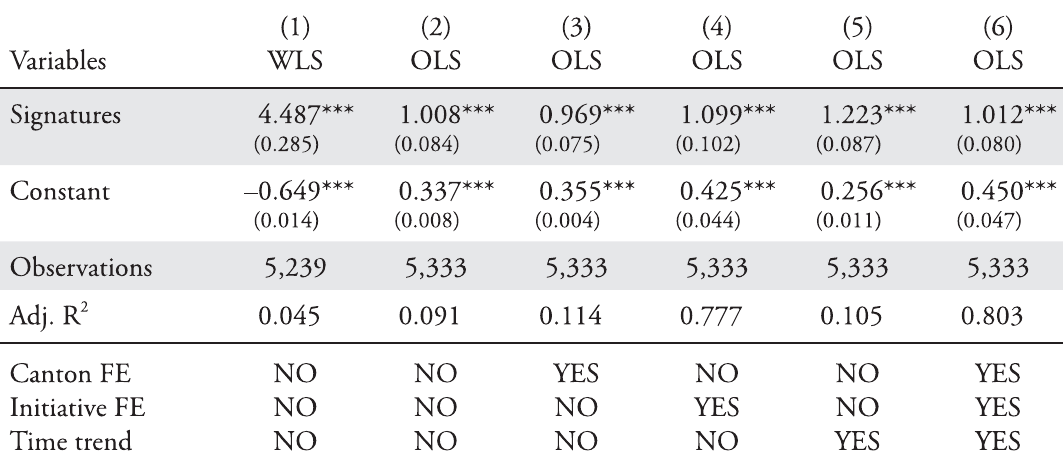
Table 2: Effect of Initiative Signing on